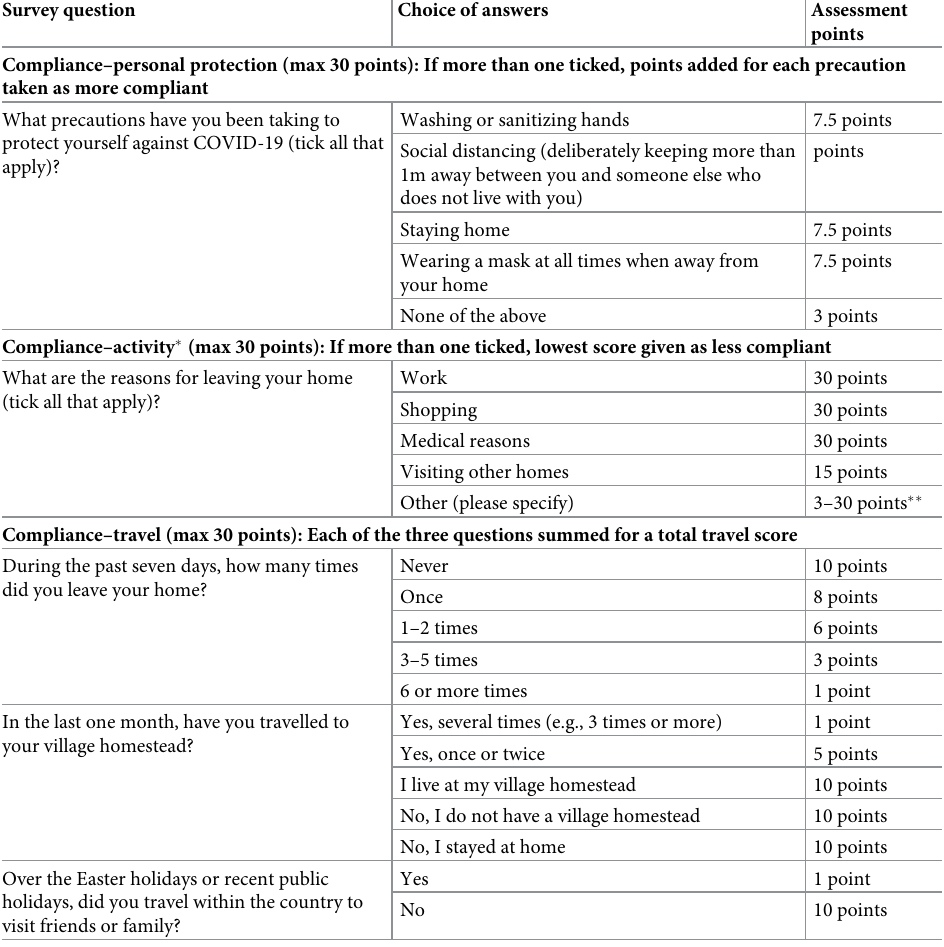
Table 1. Survey questions and scored answers related to